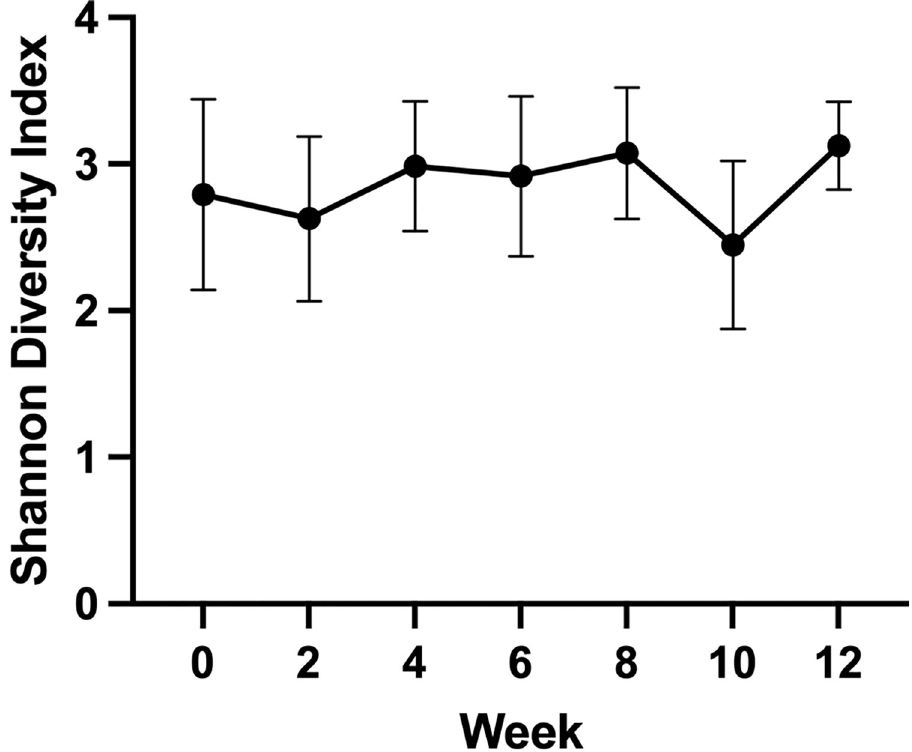
Fig 3. Shannon diversity index. Mean +/- standard deviation Shannon diversity index. There was no significant difference over time (p = 0.32).